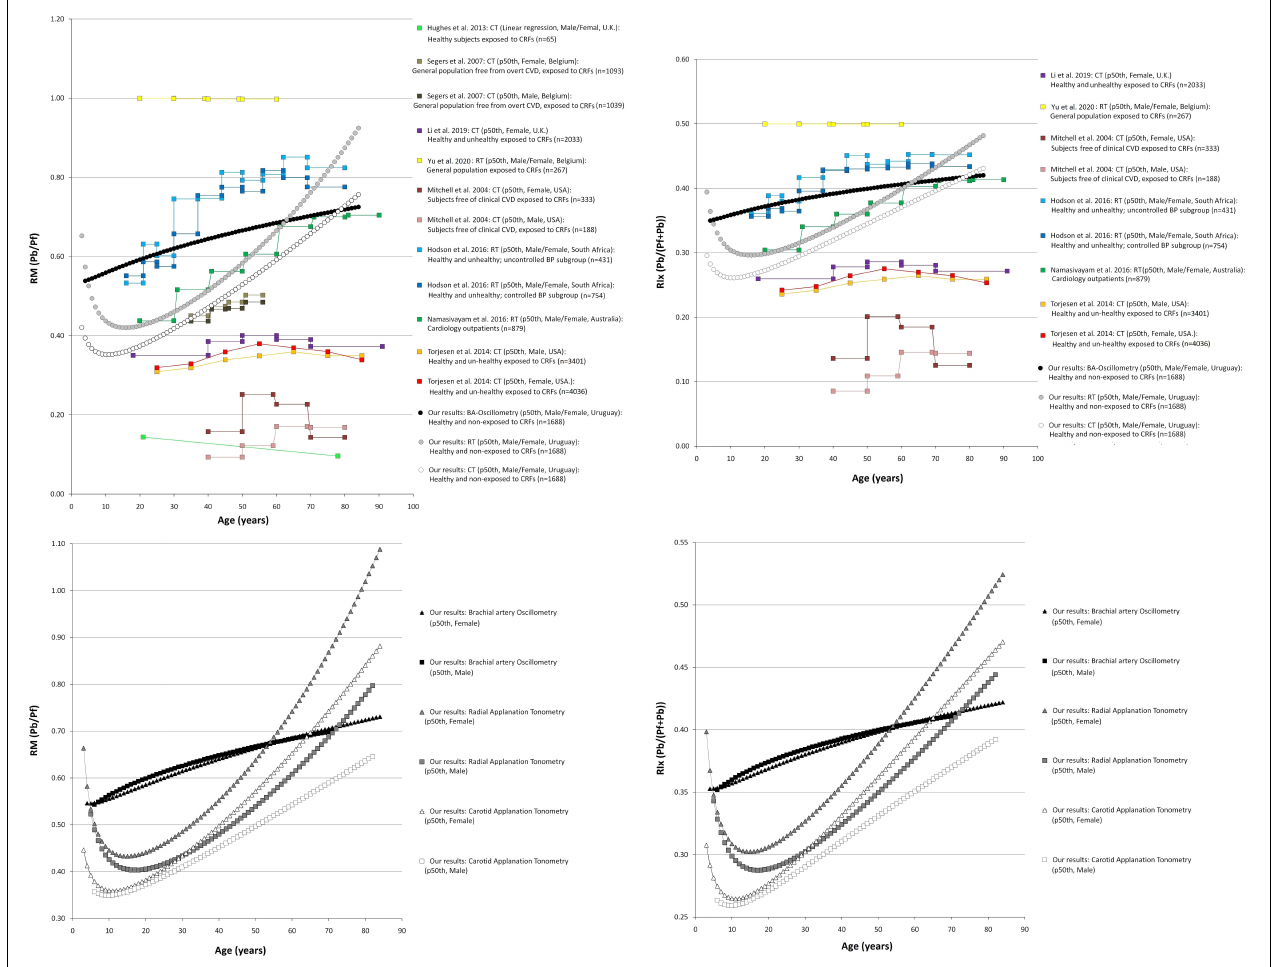
FIGURE 4 | Reflection magnitude (RM) and Reflection index (RIx) age-related profiles. Top: Comparison between curves obtained in our study (p50th) and mean values or p50th obtained by other authors. Pb and Pf, backward and forward pressure; CT, carotid applanation tonometry; CVD, cardiovascular disease; CRFs, cardiovascular risk factors; RT, radial applanation tonometry; U.K., United Kingdom; United States, United States of America; BP, blood pressure; BA, brachial artery. Bottom: Age-related profiles (p50th) for males and